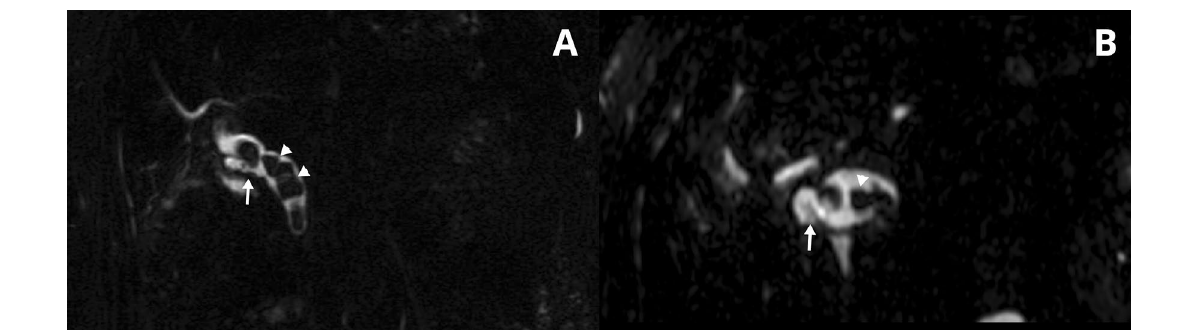
Fig. 3 A patient with mid-lateral insertion of cystic duct and choledocholithiasis. The coronal a MRCP image depicts the mid insertion level, and the axial b MRCP image shows the lateral insertion site. Note the insertion point (arrows) and the multiple stones (arrowheads) in the common